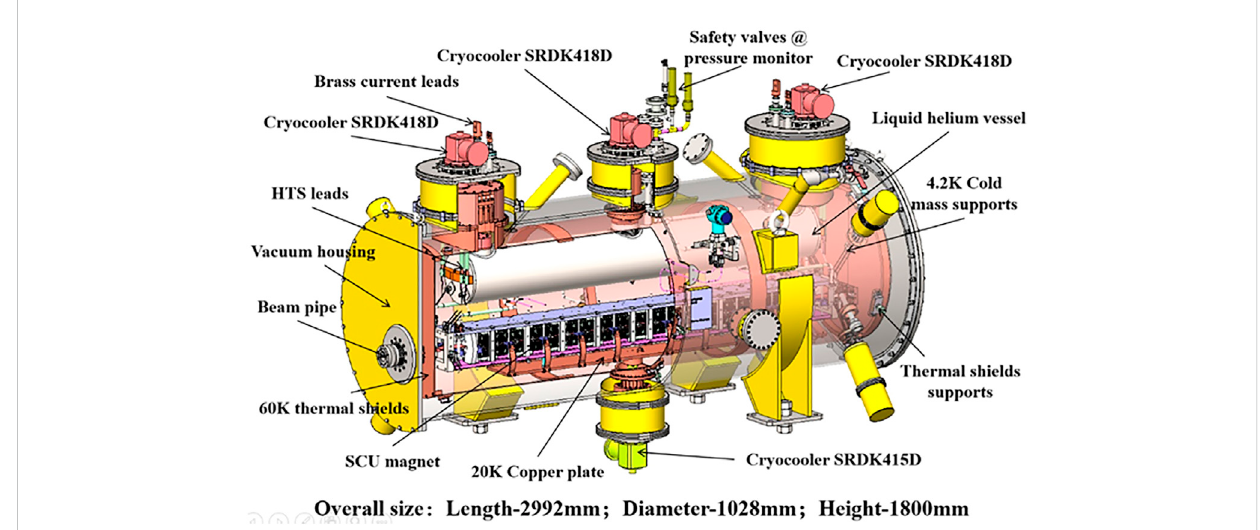
FIGURE 13 Schematic representation of the 1.5-m-long SCU test cryostat.